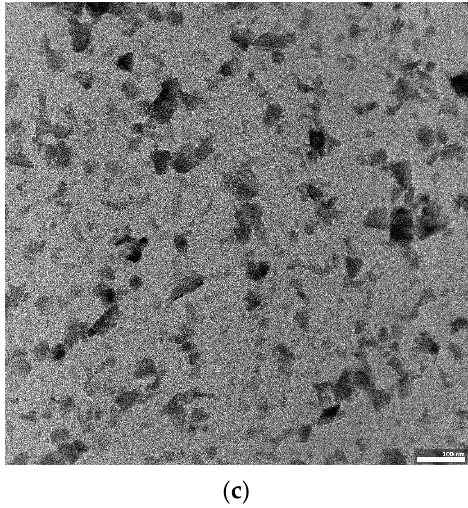
Figure 2. The structure and morphology of B4C powder centrifuged for 1.5 h. ( a – c ) present the differentiation in morphology of the obtained boron carbide nanoparticles in increasing magnification. TEM visualization using a JEOL JEM-F200 80 kV TEM (scalebars 100 and 200 nm).